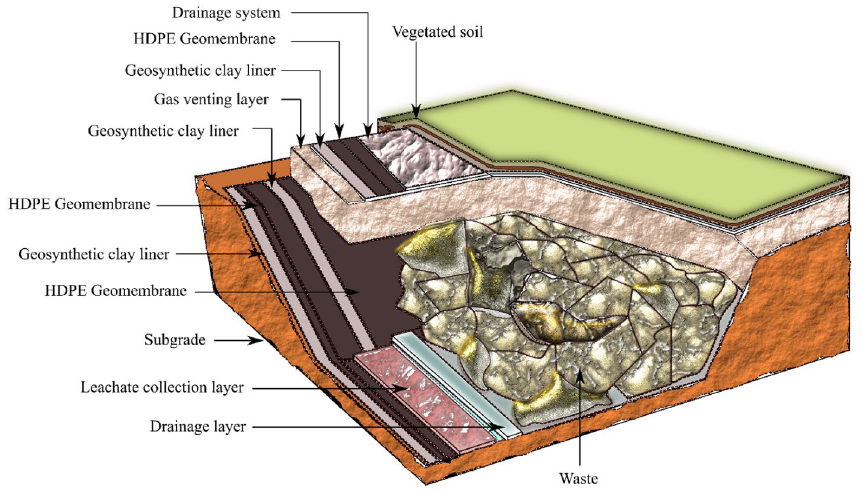
Figure 1. Schematic diagram of an engineered